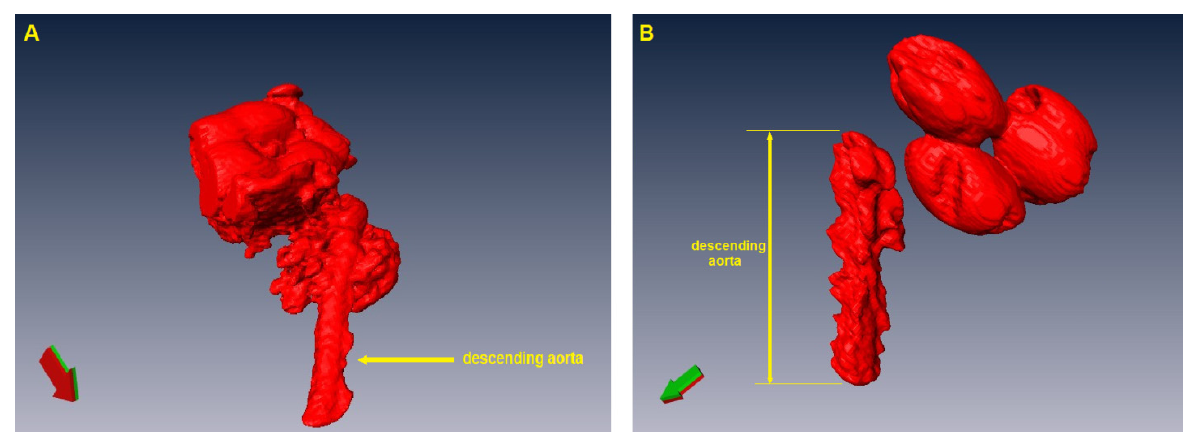
Figure 2. 3D reconstruction of rat aorta and heart: ( A ) aorta and heart before the removal of ascending aorta and aortic arch; ( B ) selected descending aorta used for volume evaluation, and the isolated heart.